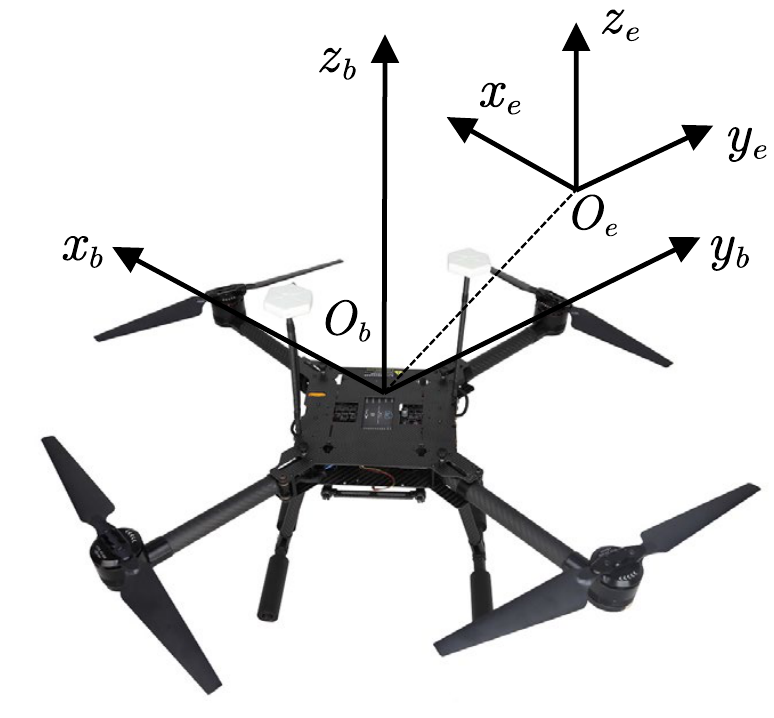
Figure 1. The structure of the